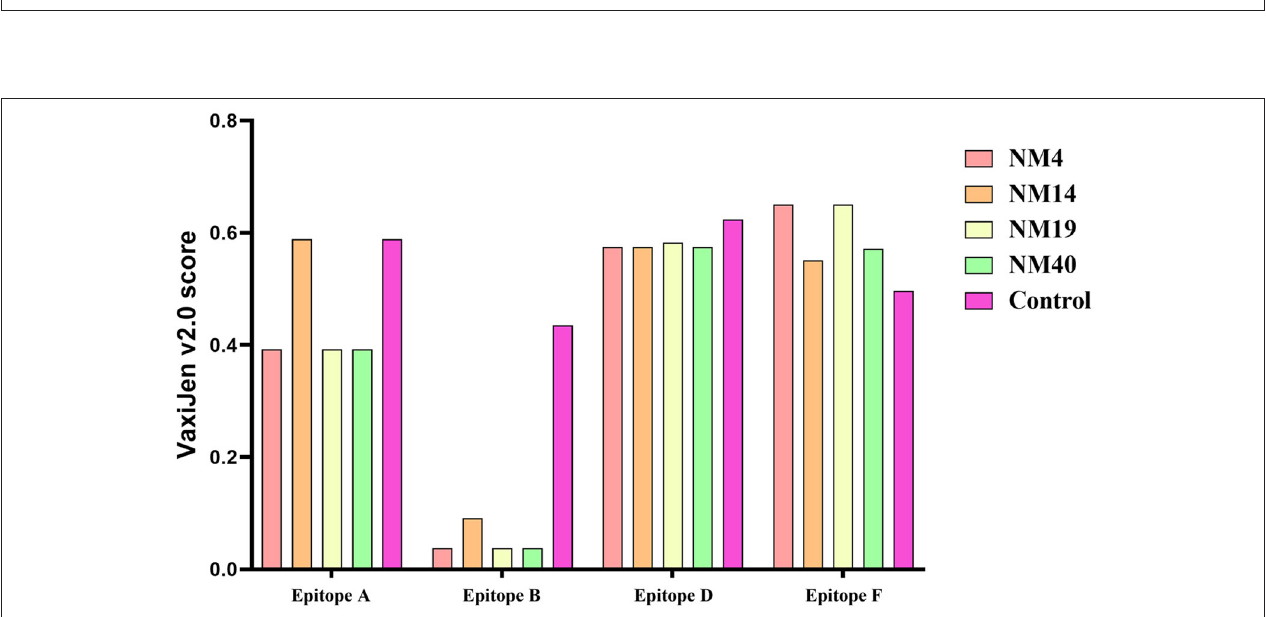
FIGURE 7 | Antigenicity testing of epitopes A, B, D, and E in PPV7 strains was performed with the VaxiJen v2.0 server online tool. The control were the VaxiJen v2.0 scores of epitopes reported by wang et al. (24).